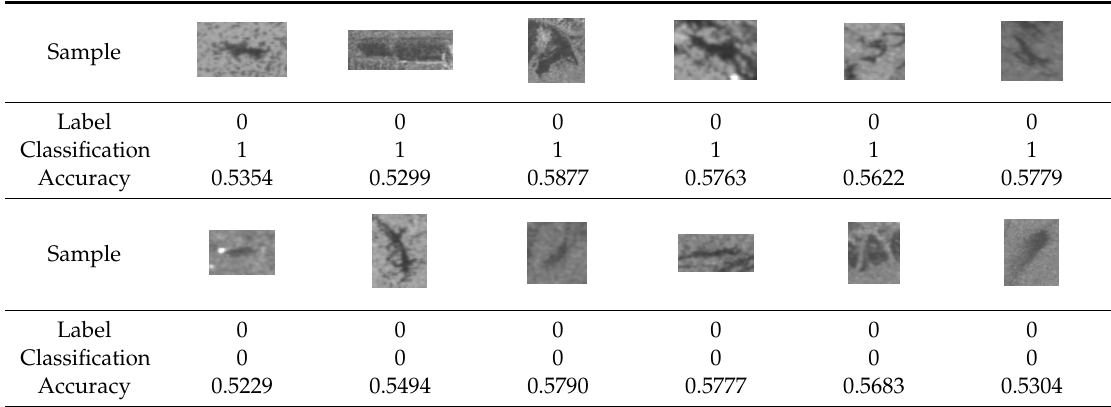
Table 13. Examples of lookalikes hard to classify.